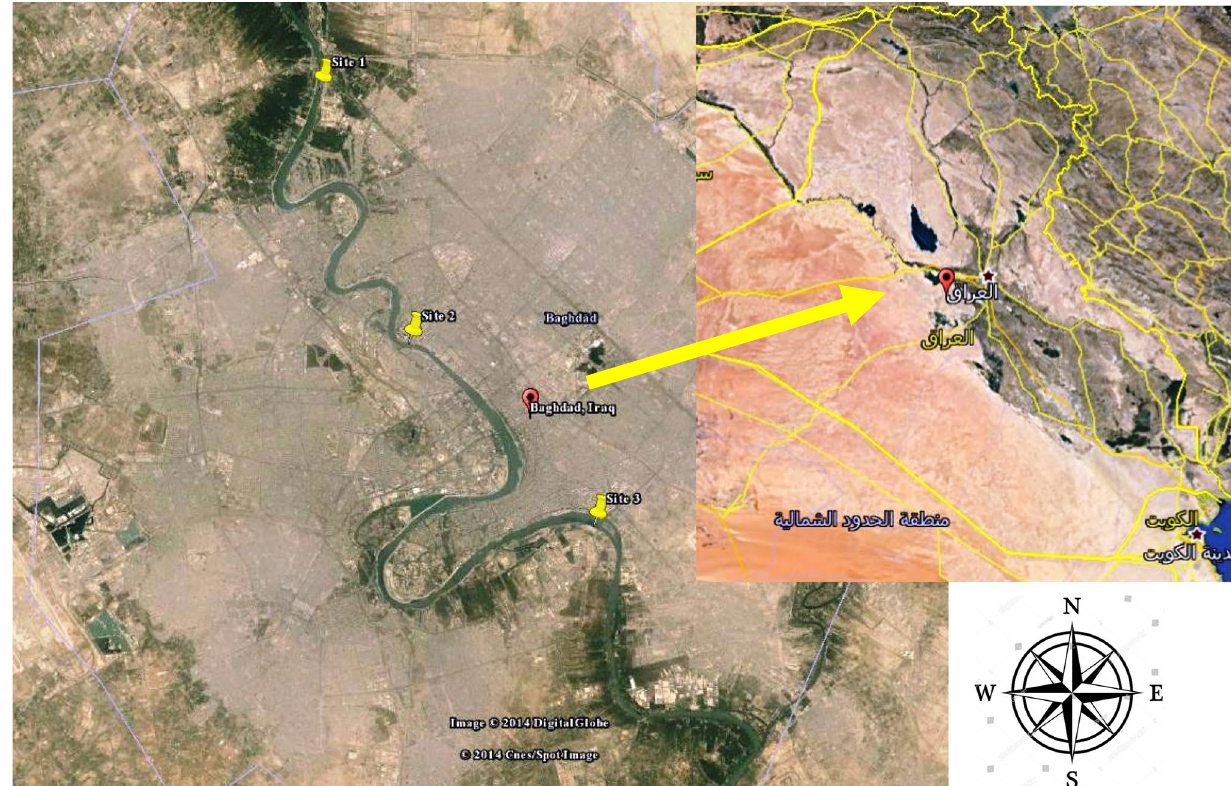
Fig. 1 Map of Iraq and the sediment sampling sites across Tigris River within Baghdad